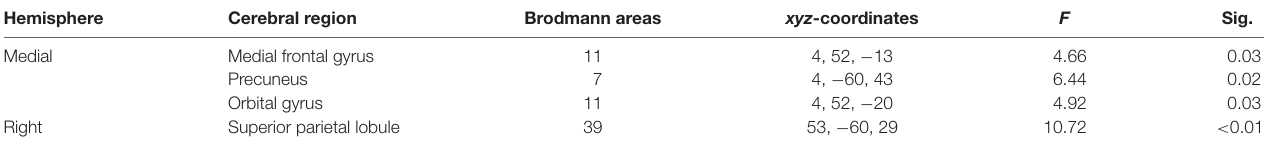
TABLE 2 | Detailed low-resolution brain electromagnetic tomography (LORETA) results of the high time resolution analysis with significant differences in brain electrical activity during three conditions from 300 ms to 700 ms. Hemisphere Cerebral